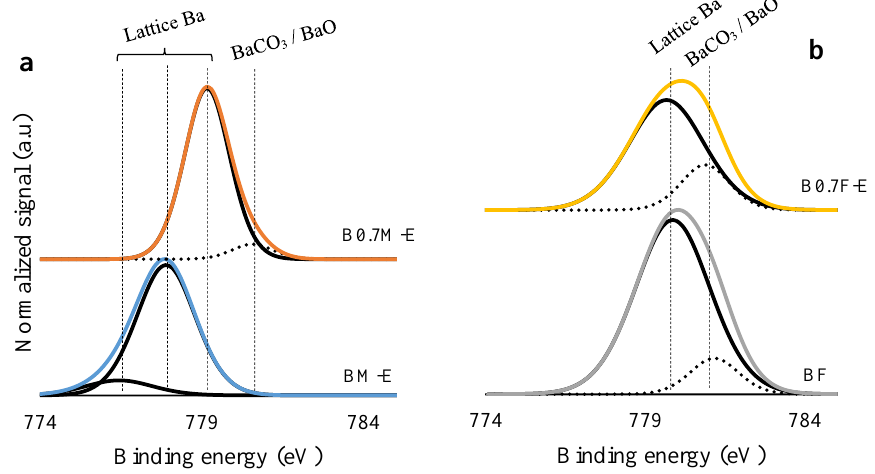
Figure 3. XPS spectra of the Ba 3d 5/2 transition for BM-E and B0.7M-E ( a ) and for BF and B0.7F-E ( b ) catalysts.